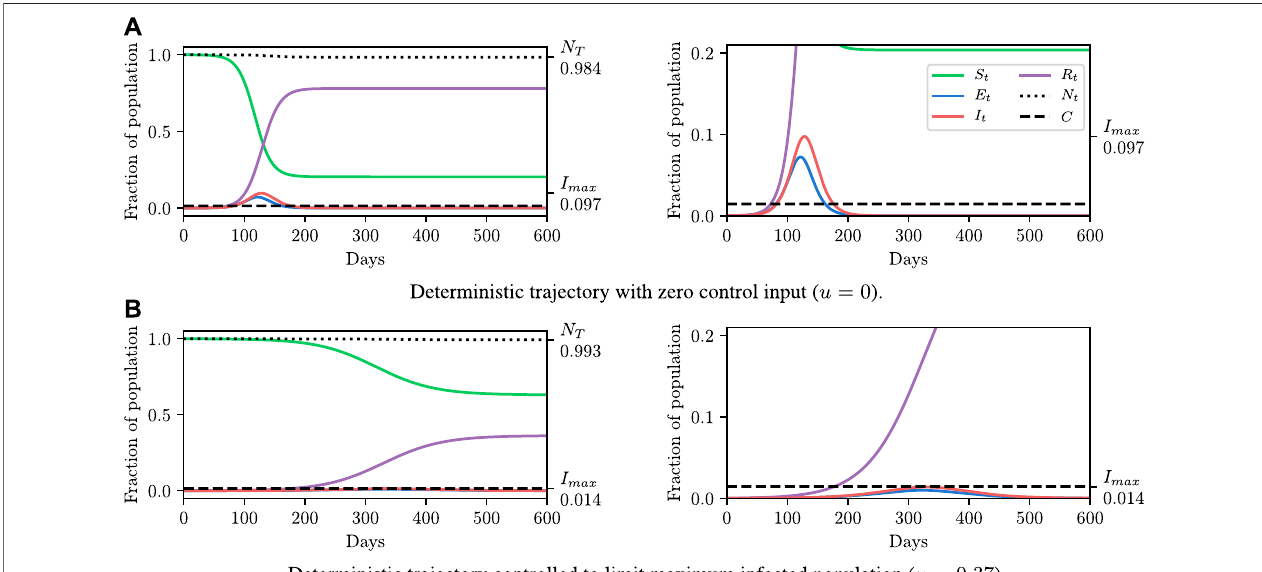
FIGURE 2 | Populations per compartment during deterministic SEI 3 R simulations, both without intervention (A) and with intervention (B) . Plots in the left column show the full state trajectory, and in the right column are cropped to more clearly show the exposed and infected populations. Without intervention, the infected population requiring hospitalization (20 % of cases) exceeds the threshold for infected population (0.0145, black dashed line), overwhelming hospital capacities. With intervention ( u (cid:1) 0.37) the infected population always remains belowthis limit. Note that we re-use the colour scheme from this fi gure through the rest ofthe